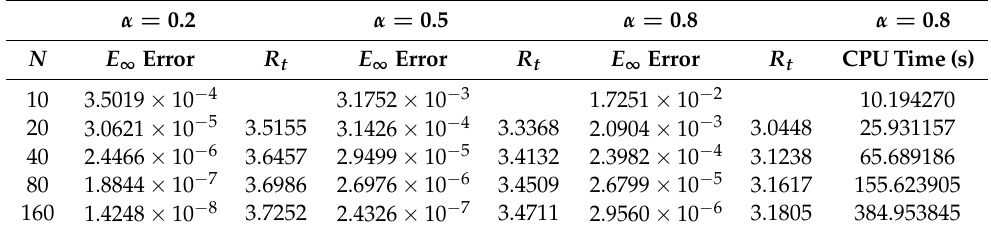
, with different 3